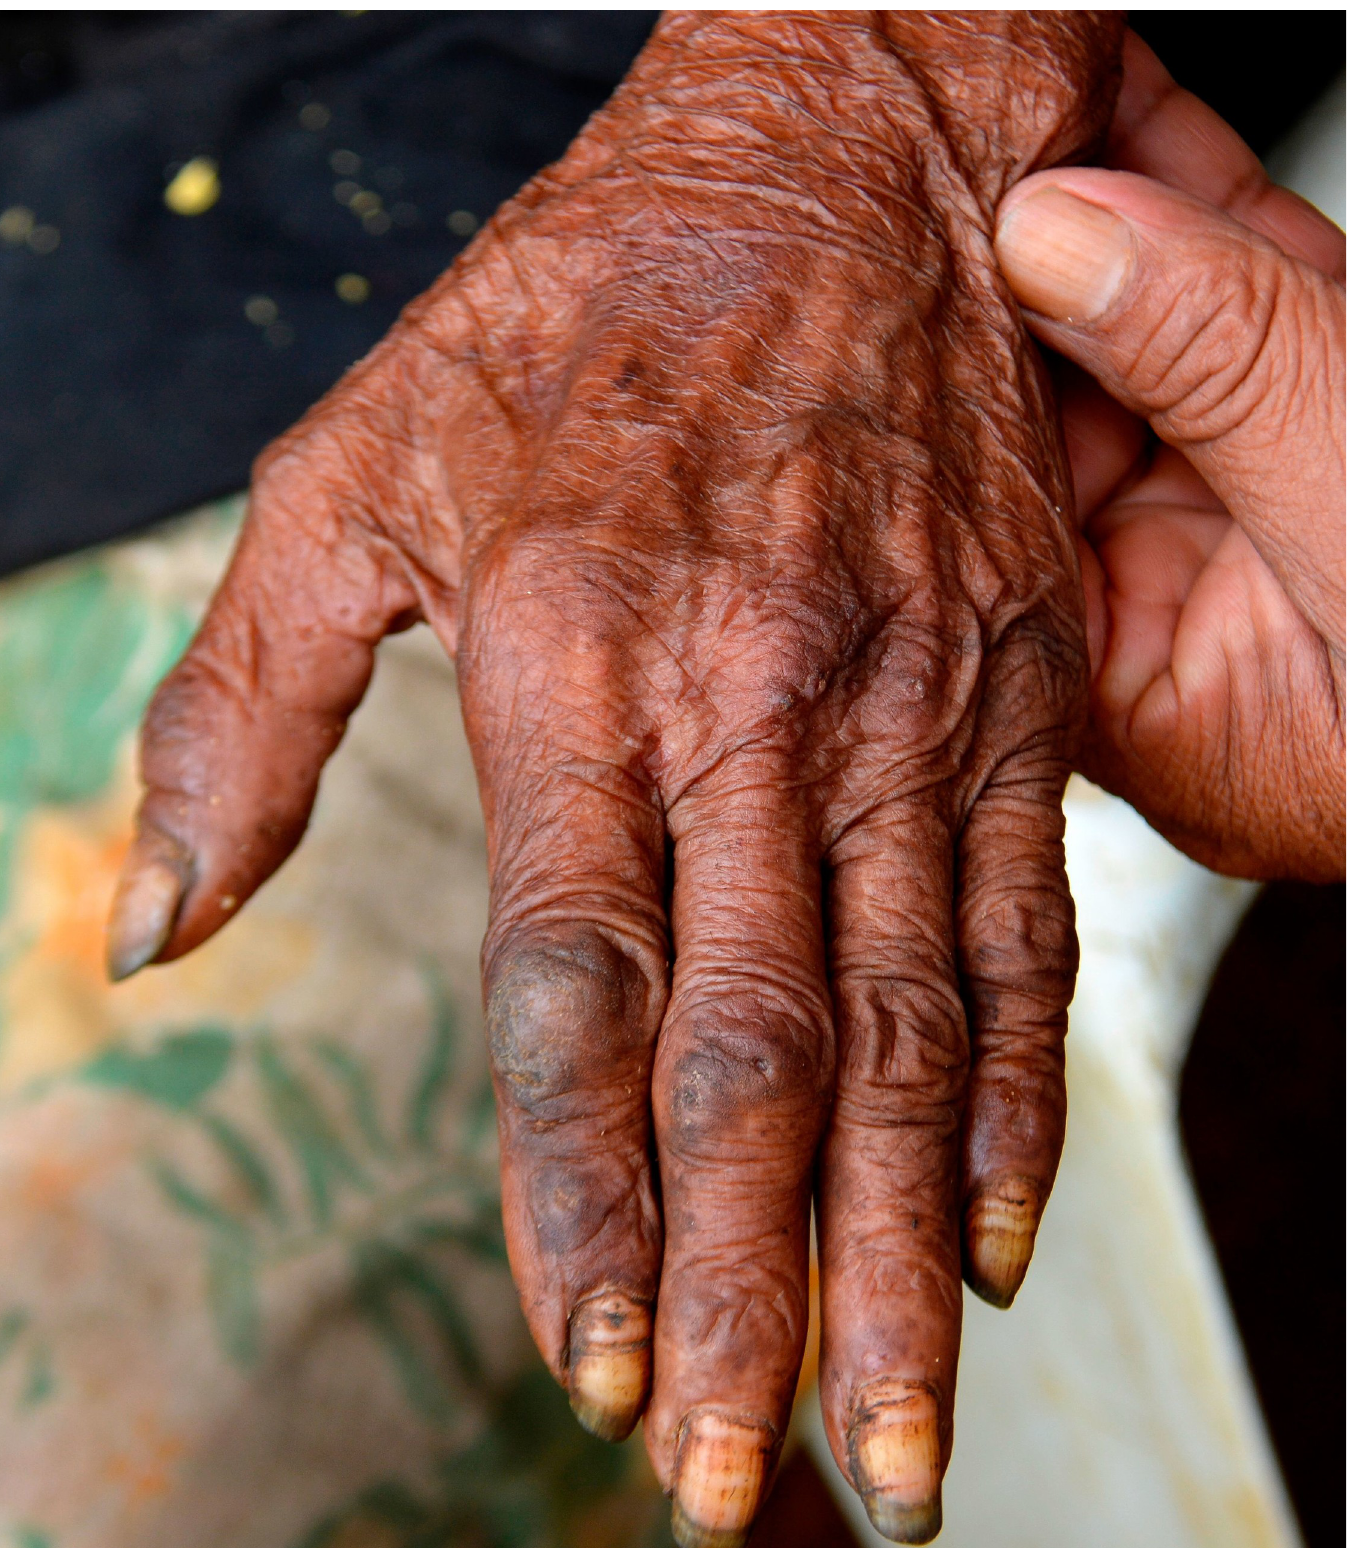
Fig 5. Ectopic localization of embedded sand fleas on the back of the hand.